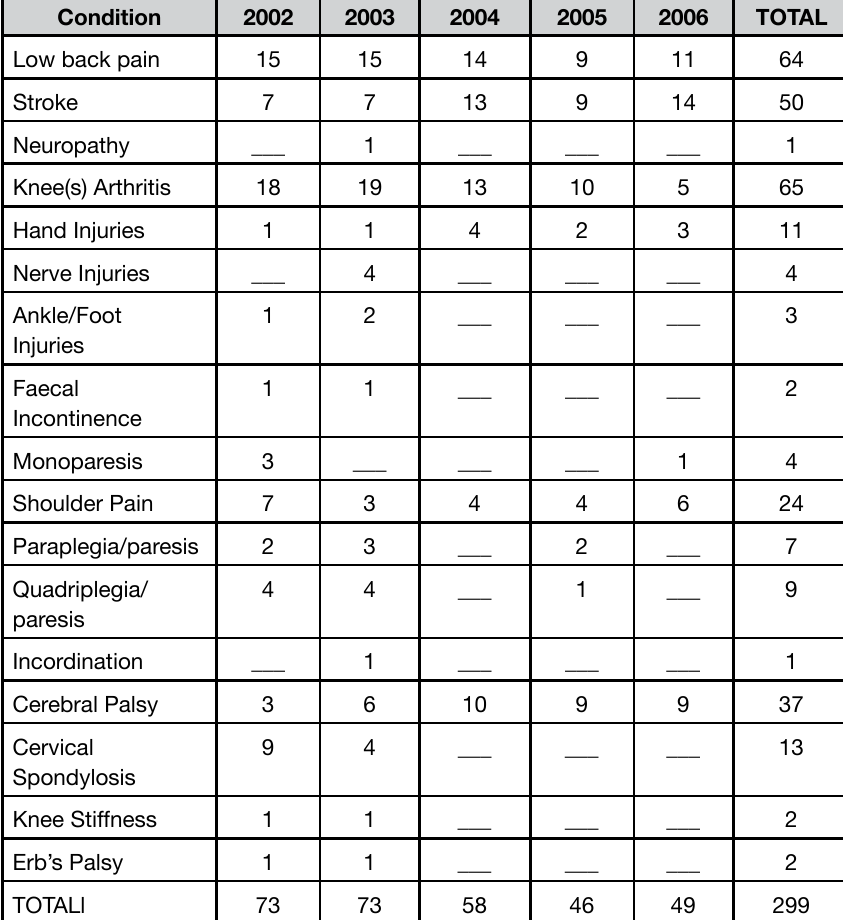
Table 3: Co-Morbid Conditions for which Individuals with Mental Illness are referred for Physiotherapy Services in the Hospital Condition